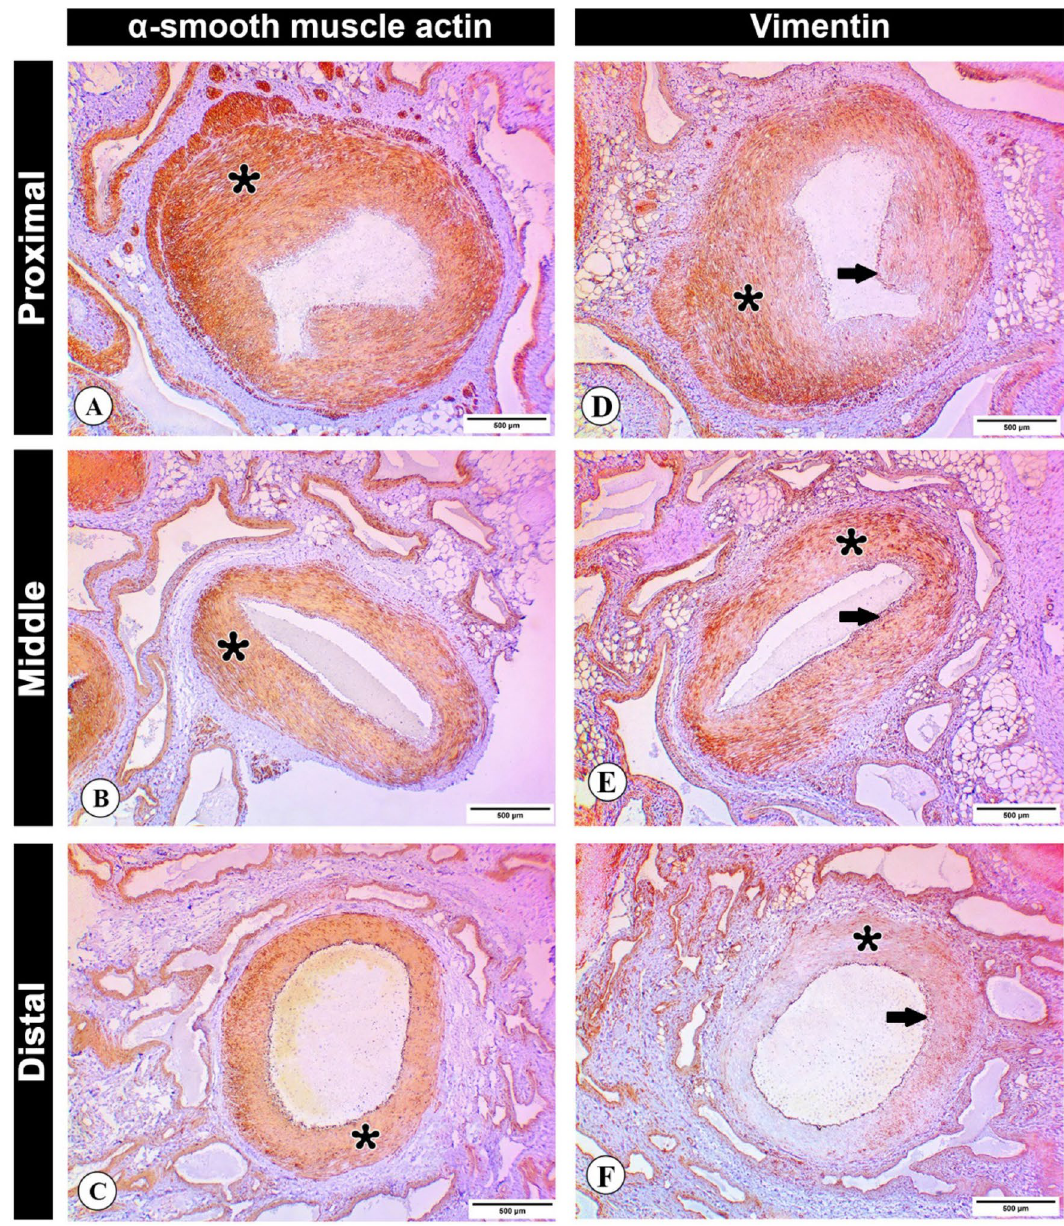
Figure 7. Immunohistochemical analysis of the testicular artery wall. ( A – C ) Photomicrographs of cross sections of proximal ( A ), middle ( B ), and distal ( C ) supratesticular zones of the testicular artery in the supratesticular region showing an immunohistochemical expression of α-SMA in tunica media (asterisks). ( D – F ) Photomicrographs of cross sections of proximal ( D ), middle ( E ), and distal ( F ) supratesticular zones of the testicular artery depicting an immunohistochemical expression of vimentin in tunica media (asterisks). Note the expression of vimentin in the endothelial cells of the tunica intima (arrows). Bar 500 Smooth muscle cells (SMCs) are the main cell type of the tunica media. These cells regulate vascular tone and blood flow through dynamic cell contraction and relaxation. α-SMA is considered the first SMC marker to be expressed during embryogenesis, and at the latest is the most considerable protein in SMCs 36 . Here, the expression of α-SMA was higher in tunica media of proximal supratesticular zone of testicular artery than in the middle and distal supratesticular zones. This reduction in the expression may be attributed to the gradual decrease of tunica media thickness distally toward the testis. Vimentin is a master intermediate filament protein in smooth muscle cells and tissues. It regulates the actin cytoskeleton in the smooth muscle 39 . Furthermore, vimentin is also expressed in endothelial cells of blood ves- sels, and that make it a good marker of microvascular distribution, since endothelial cells of blood vessels of all sizes, from capillaries to arteries, are strongly reactive 40 . Noticeably, vimentin showed immunoreactivity in the